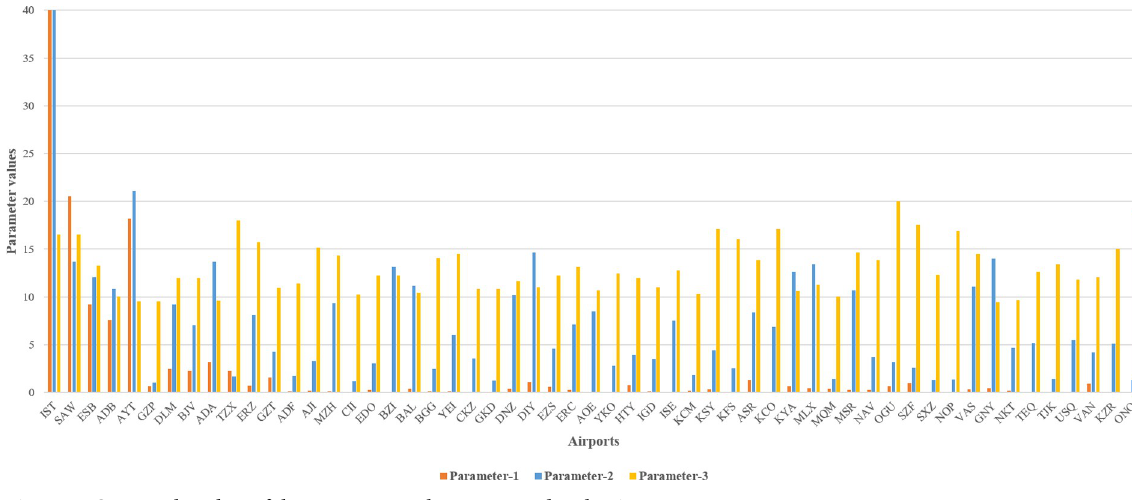
Fig 4. For Case- 24 , the values of three parameters that correspond to the